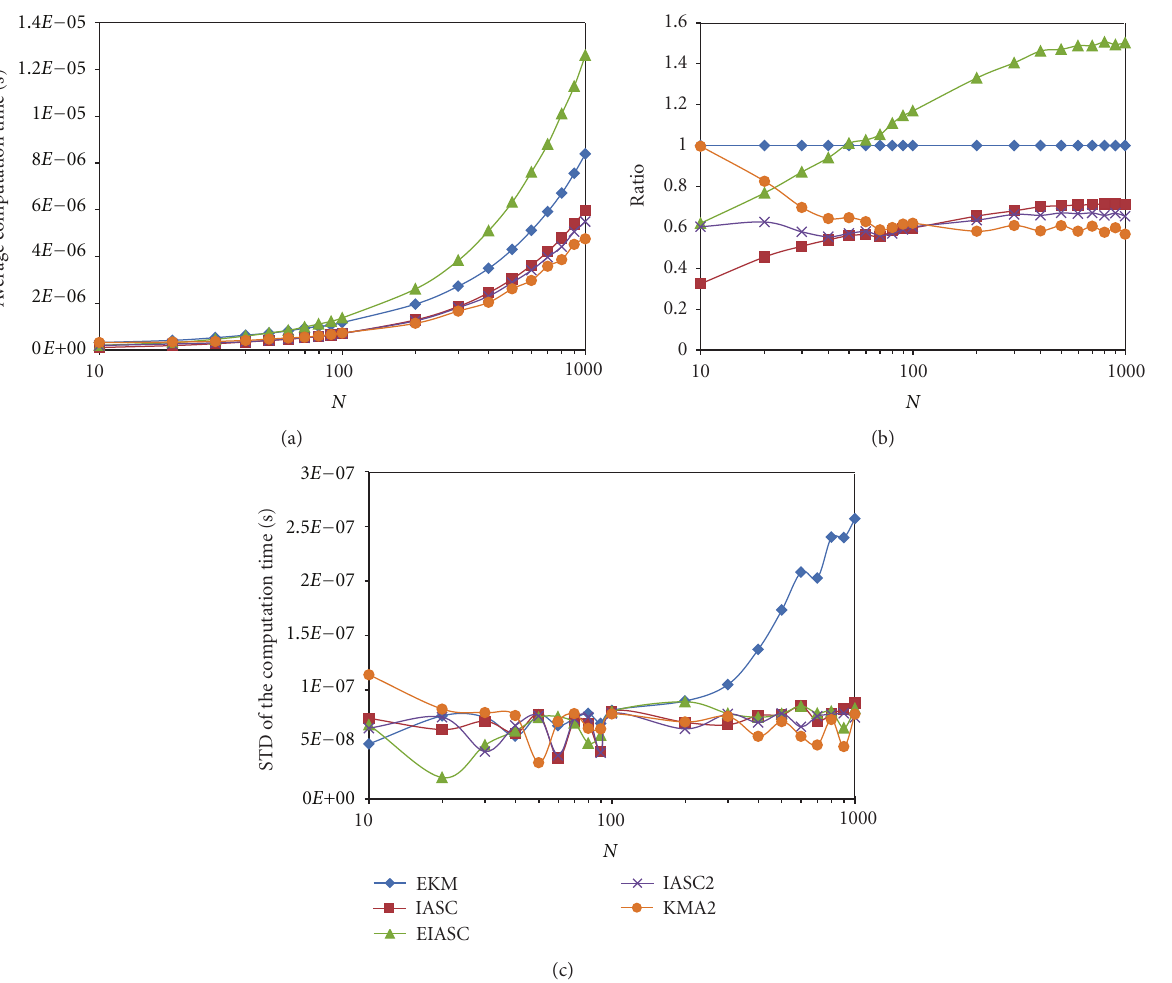
Figure 5: Left-sided random FOU results (compiled language implementation of the algorithms). (a) Average computation time, (b) ratio with respect to the EKMA, and (c) standard deviation of the computation